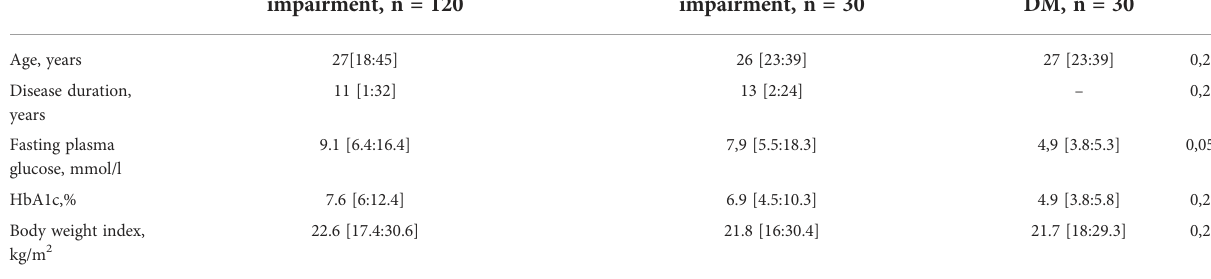
TABLE 1 Characteristics of patients with type 1 DM (Me [Q1; Q3]). Parameters